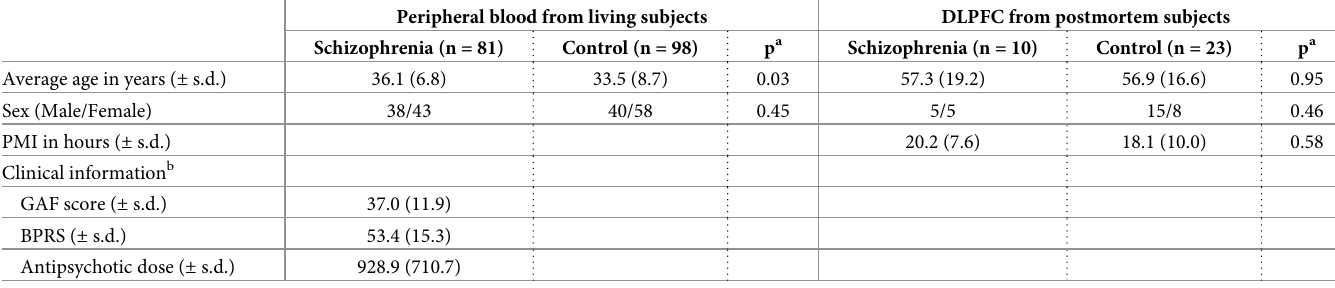
Table 1. Demographic and clinical details of the